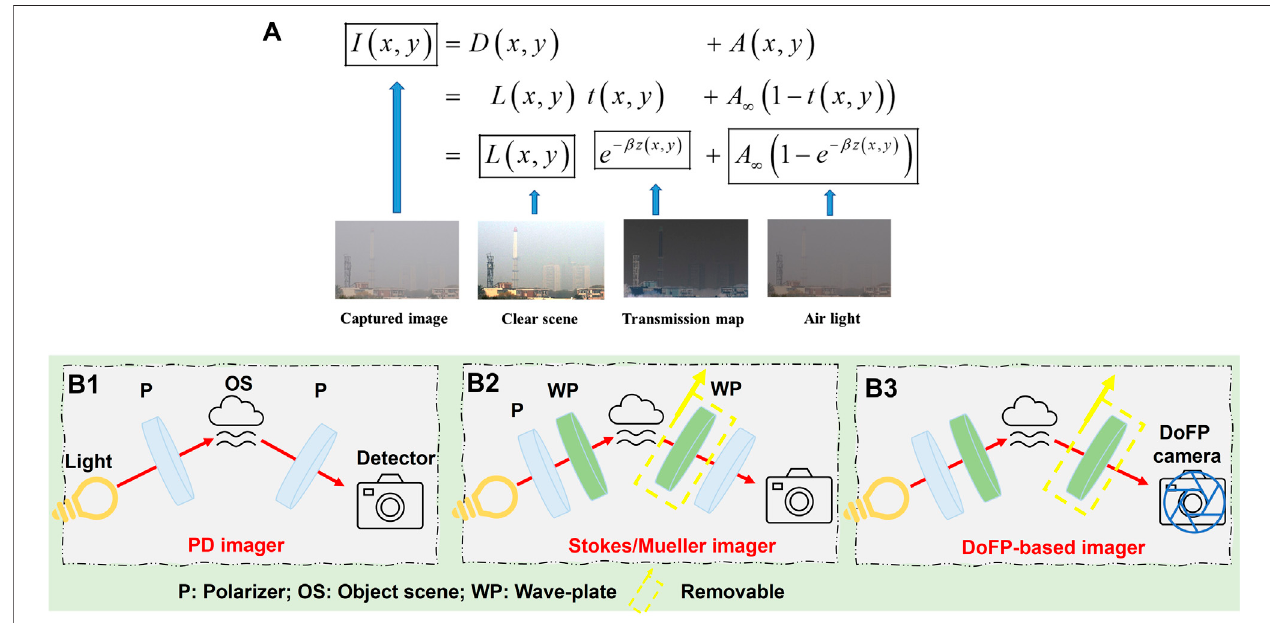
FIGURE 2 | (A) Image formation and visual example of illumination components through the turbid media (reprinted from Springer Nature: Scienti fi c Reports [2], copyright 2018). (B) Different polarimetric imaging systems: (B1) PD imager, (B2) Stokes/Mueller imager, and (B3) DoFP camera-based imager.